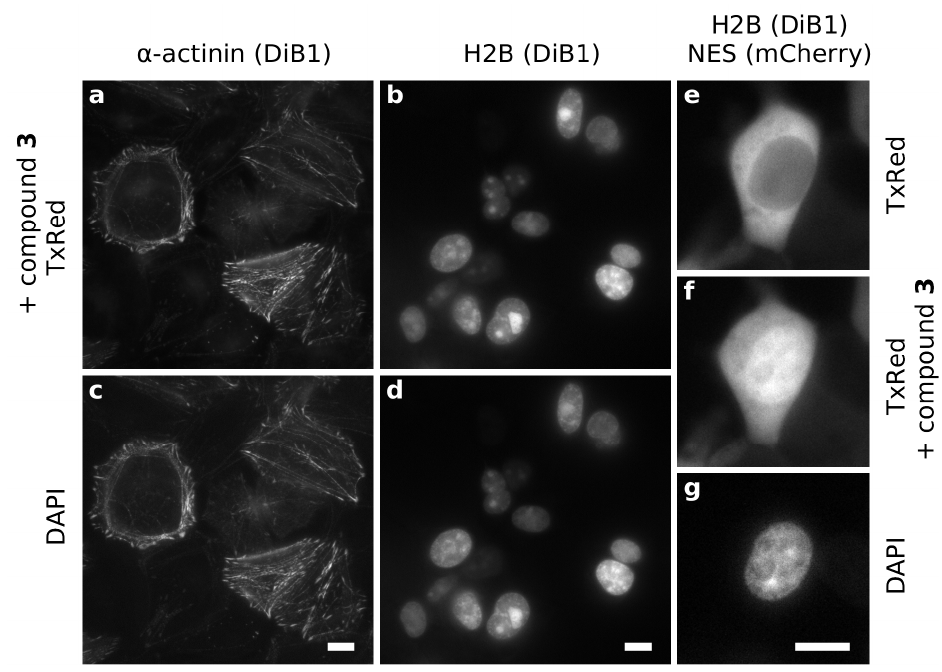
Figure 2 . Live-cell protein labeling using DiB1: Compound 3 pair. ( a , b , e , f ) target channel (DiB1 imaged with TxRed filter set in the presence of 100 nM of the compound 3 ), ( c , d , g ) reference channel (TagBFP imaged with DAPI filter set), ( a , c ) alpha-actinin, HeLa cells ( b , d ) histone H2B, HEK293 cells ( e – g ) HEK293 cells transiently co-transfected with mCherry-NES (nuclear export signal) and TagBFP-DiB1-H2B, before ( e ) and 5 min after ( f ) addition of the compound 3 (100 nM). Scale bars 10 µ m. Int. J. Mol. Sci. 2018 , 19 , x FOR PEER REVIEW